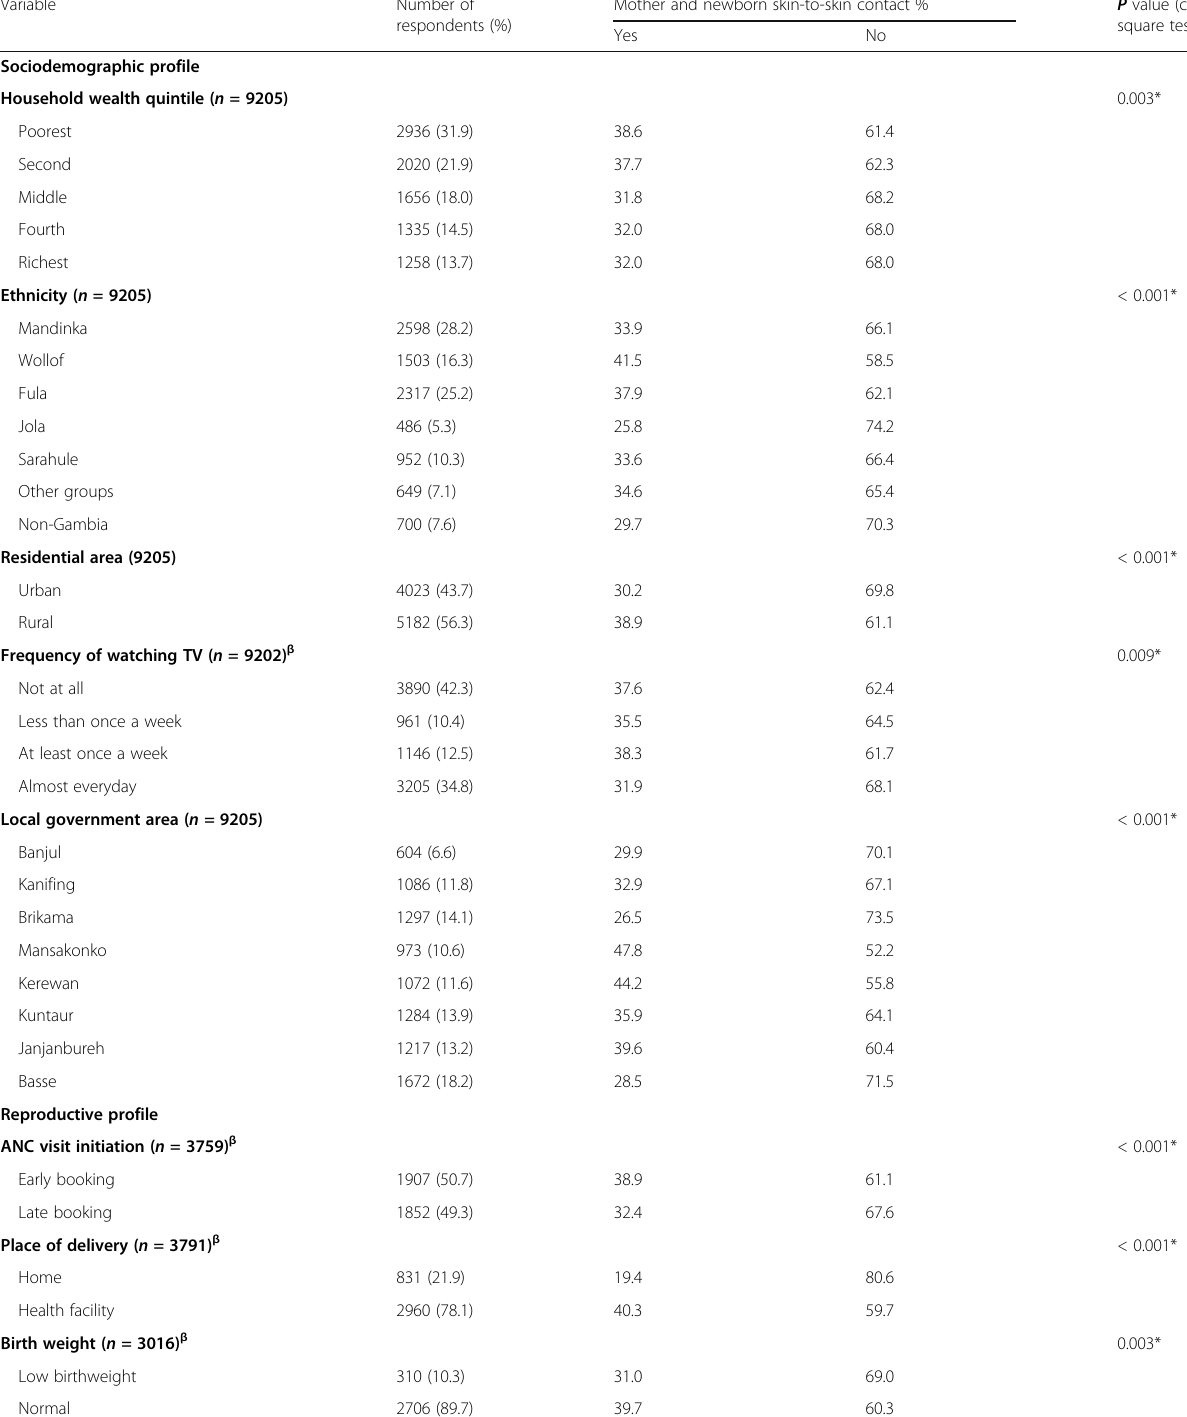
Table 1 Distribution of early mother and child skin-to-skin contact in The Gambia by selected socio-demographic and reproductive variables ( n =